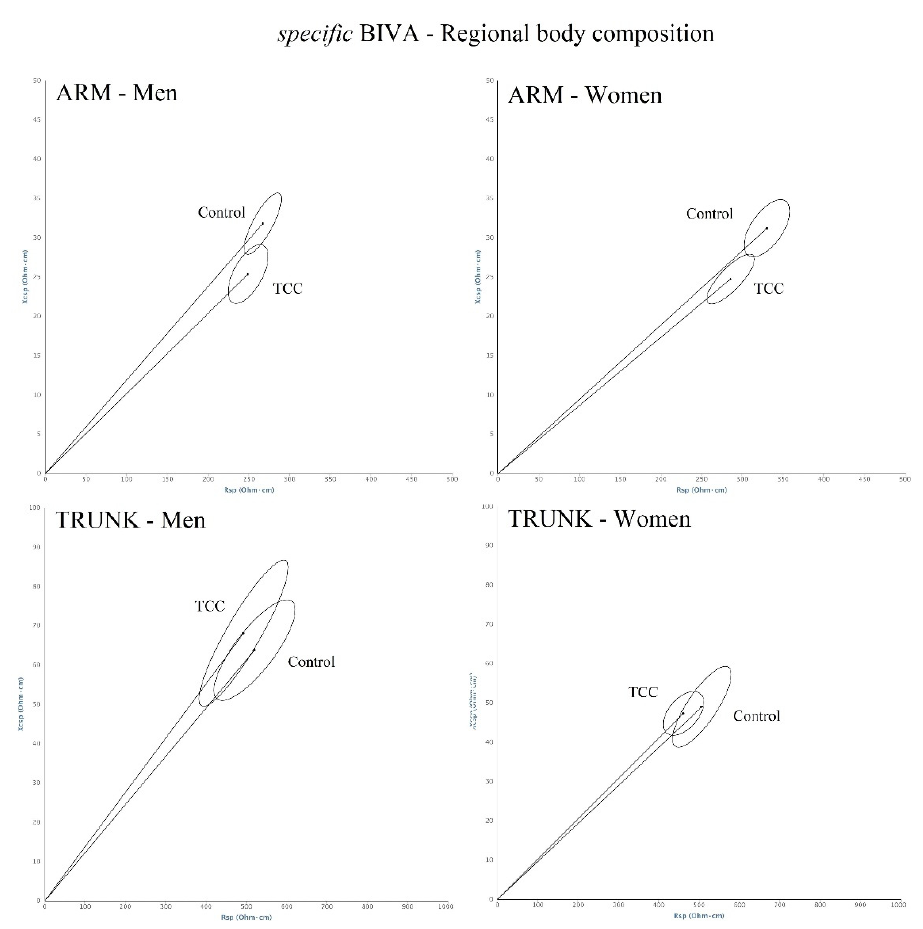
Figure 3. Regional confidence ellipses. Comparison between TCC group and controls. Arm (men: T 2 = 9.8, p = 0.001; women: T 2 = 11.2, p = 0.007); trunk (men T 2 = 2.7, p = 0.285; women T 2 = 2.2, p = 0.340).